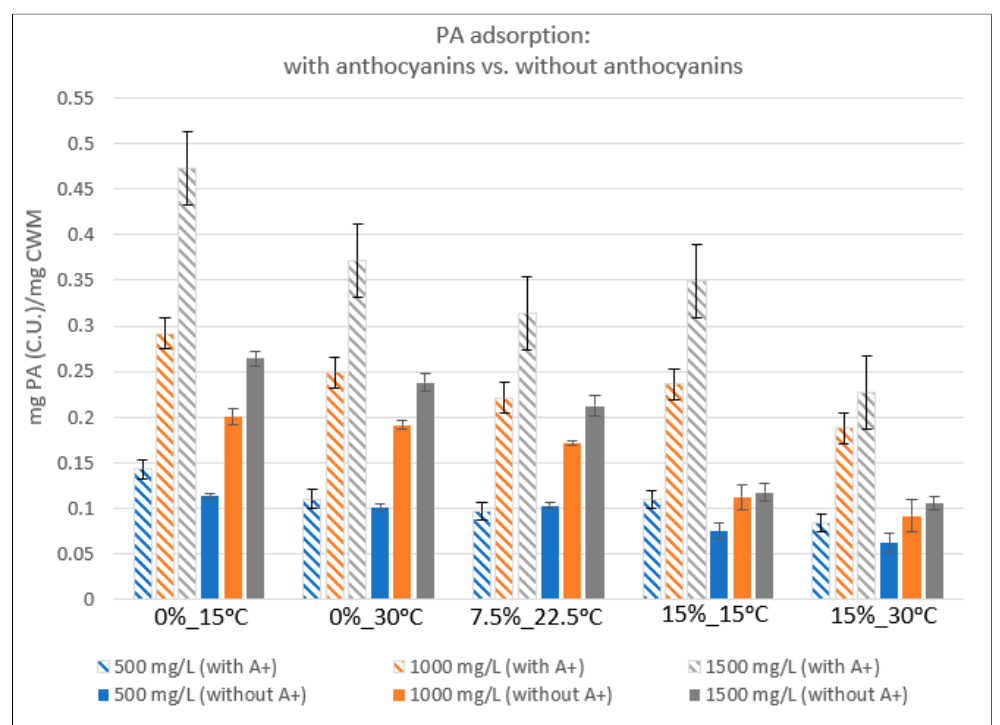
Figure 6. Relative PA adsorption to CWM under variable temperature and ethanol in the presence or absence of anthocyanins ( n = 3). “A + ” = anthocyanins. All “Without A + ” values were derived from a previous study [7]. “A + ” = anthocyanins.